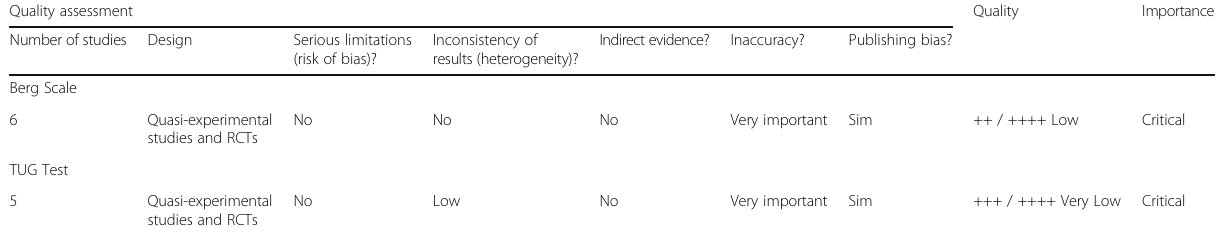
Table 5 GRADE system quality of evidence analysis for the Berg Balance Scale and the Timed Up and Go (TUG) test Quality